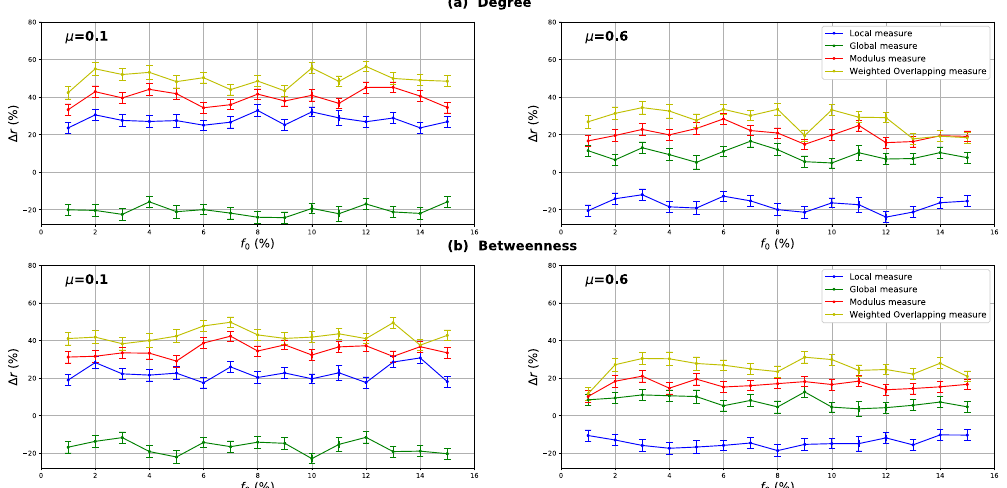
Figure 21. The relative difference of the outbreak size Δ r as a function of the fraction of initial spreaders f 0 . The Degree ( a ), Betweenness ( b ) centrality measures derived from the Overlapping Modular centrality are compared to their standard counterpart. Two synthetic networks (LFR) with respectively well-defined ( μ = . 0 1 ) and loose community structure ( μ = . 0 6 ) are used. The measures are performed using the SLPA detection